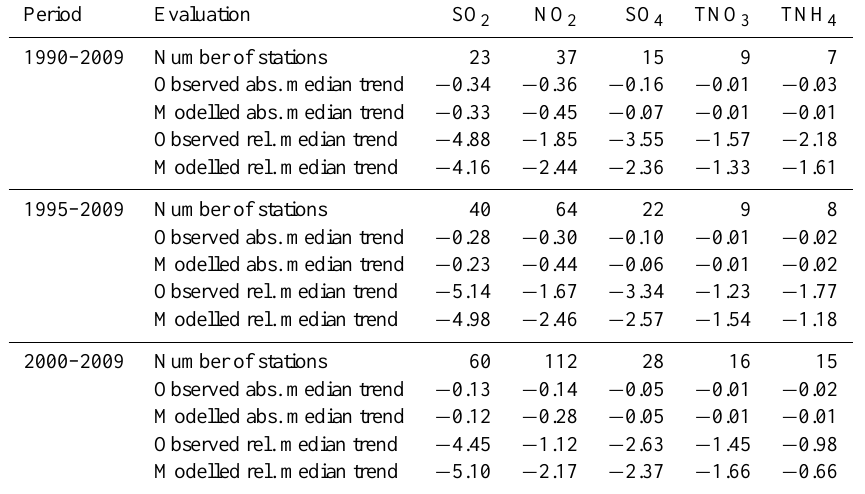
Table 6. Number of stations and derived observed and modelled absolute (µgm − 3 a − 1 ) and relative (%a − 1 ) median trends for the considered components and time